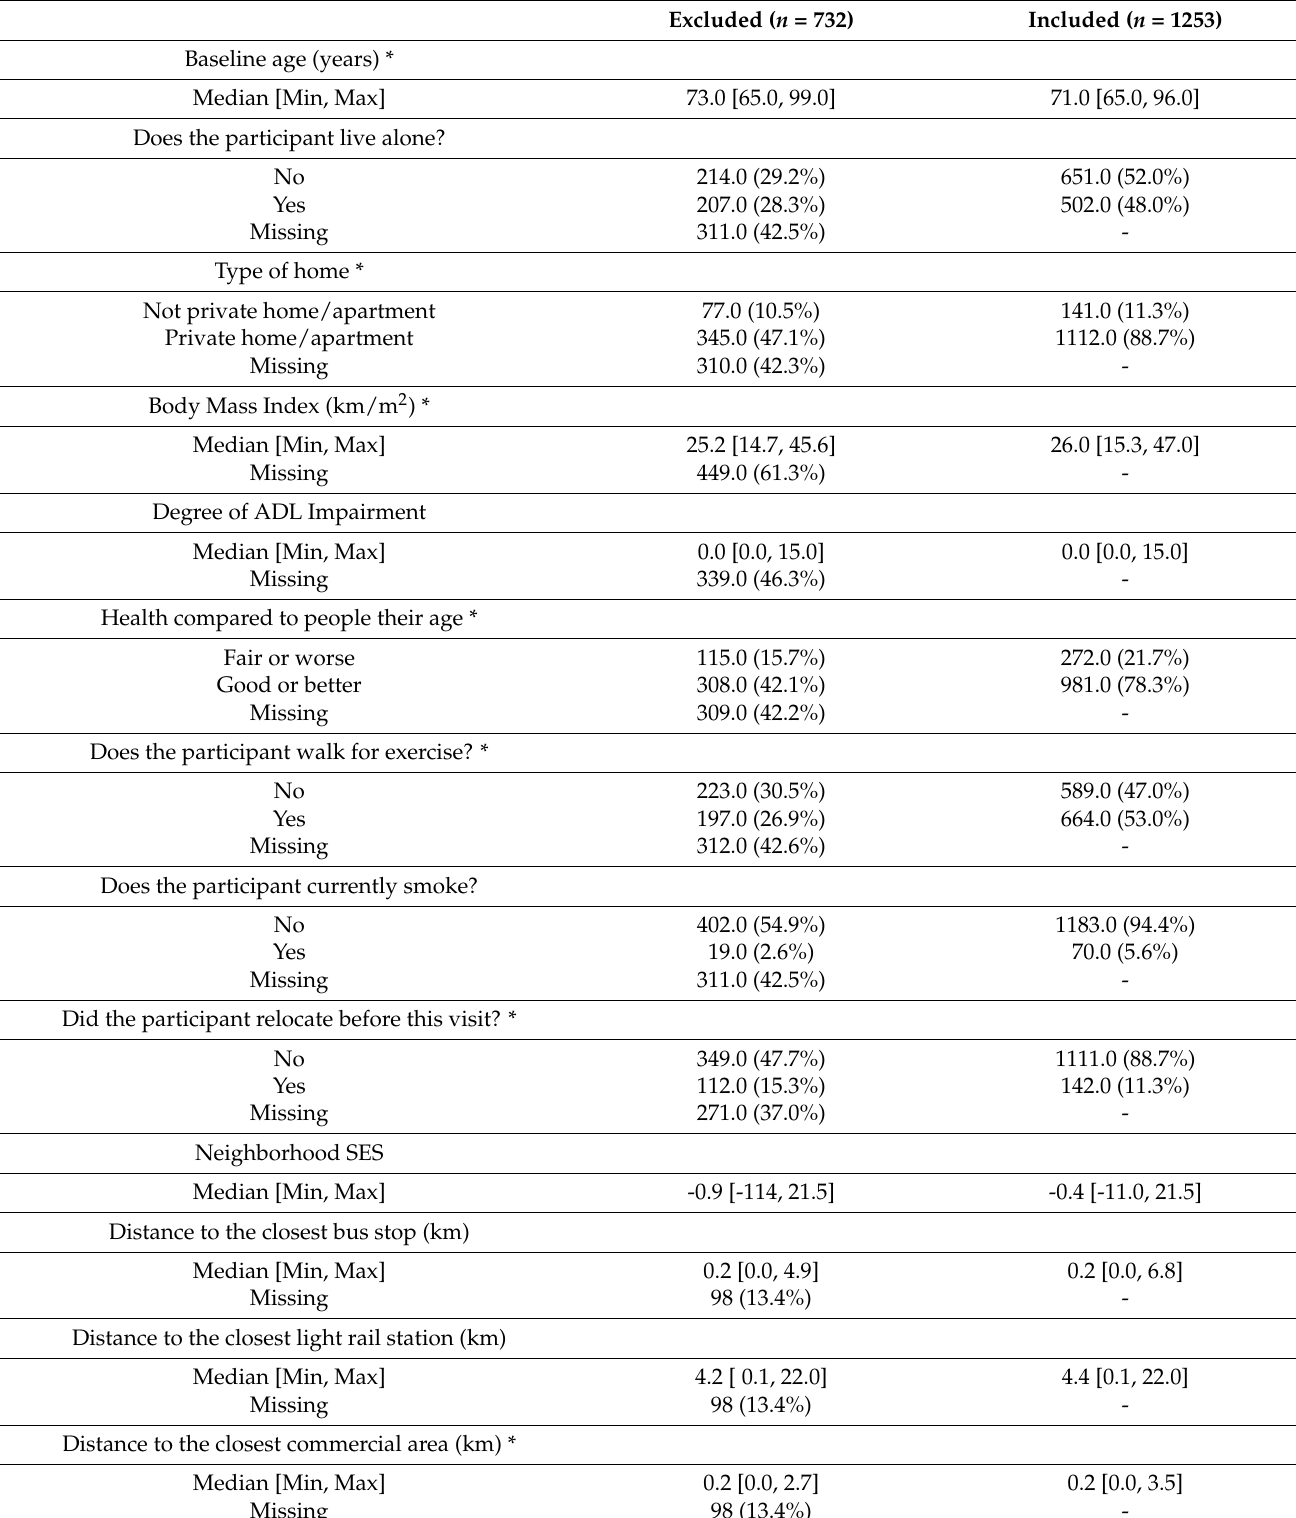
Table A1. Baseline characteristics of included and excluded